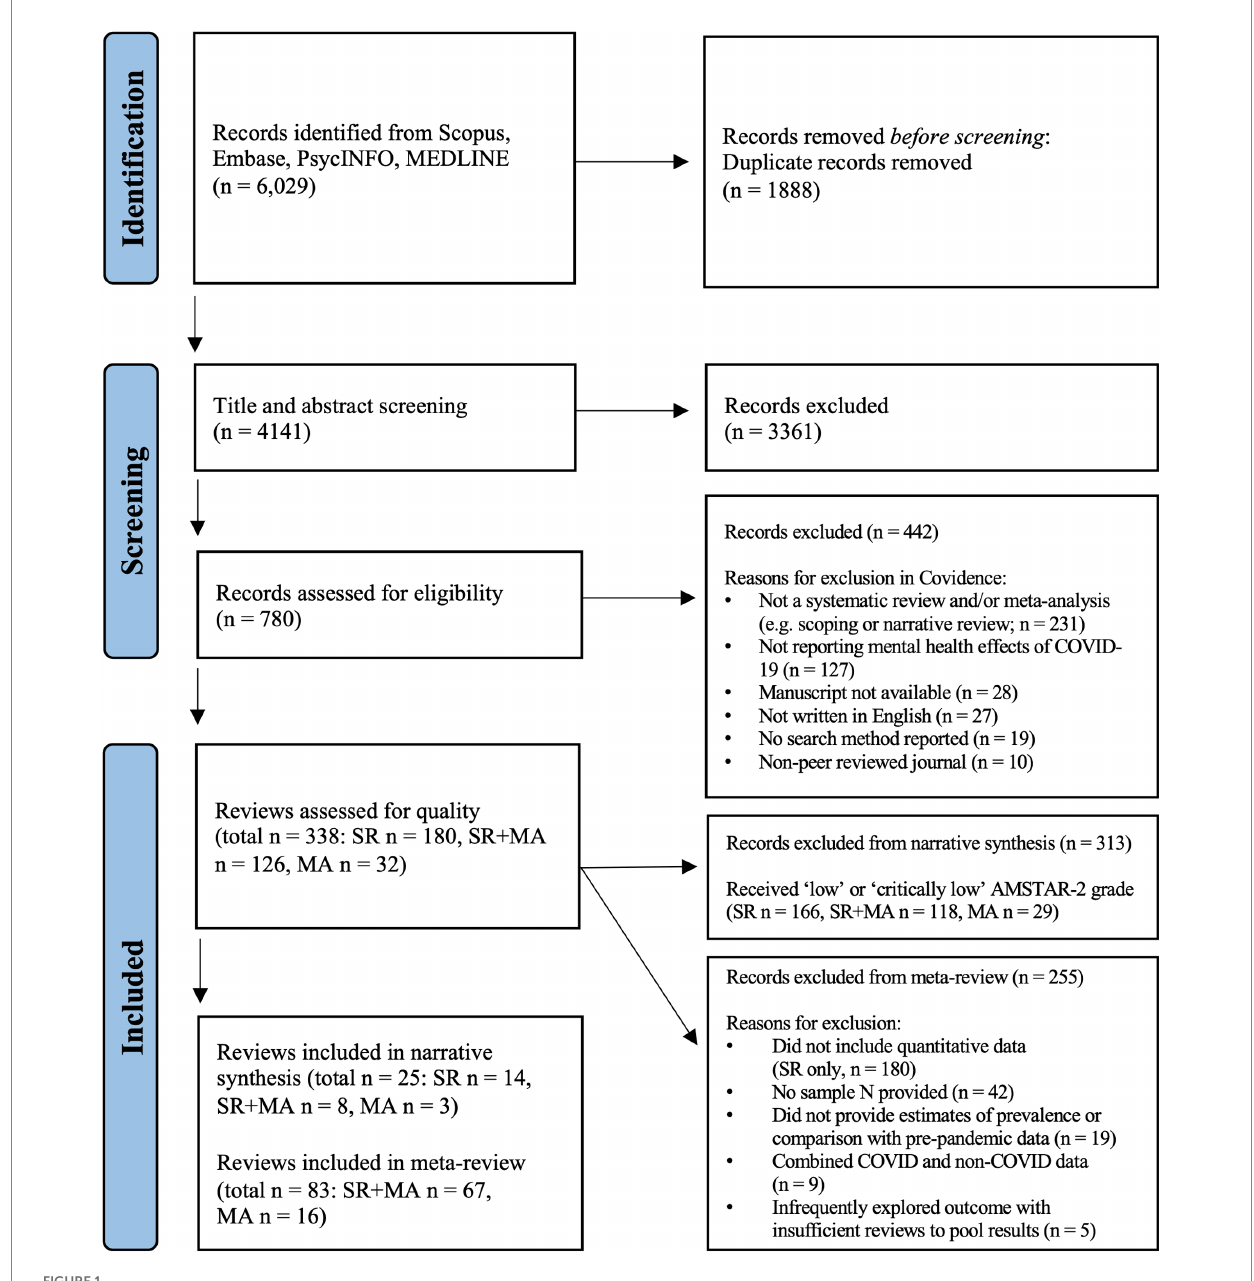
FIGURE 1 PRISMA diagram. PRISMA flow diagram outlining the progression of the 5-phase systematic search undertaken to retrieve articles examining the impact of COVID-19 on mental health outcomes. Phase 1: The initial search across four databases (Scopus, Embase, PsycINFO, MEDLINE) yielded 6,029 records, of which 1,888 articles were identified as duplicates, and removed before screening commenced. Phase 2: The titles and abstracts of 4,141 records were screened for relevance, which led to 3,361 records being excluded. Phase 3: Subsequently, 780 articles underwent full-text screening, with 442 records removed prior to quality appraisal. Phase 4: Of the 338 reviews assessed for quality using the AMSTAR-2 critical appraisal tool, 313 records were excluded from the narrative synthesis, and 255 records were excluded from the meta-review. Phase 5: Twenty-five records were included in the narrative synthesis, comprising 14 systematic reviews, 8 combined systematic reviews and meta-analyses, and 3 meta-analyses. There were 84 records included in the meta-review consisting of 67 combined systematic reviews and meta-analyses and 16 meta-analyses. n , number of records; SR, systematic review; MA, meta-analysis; SR + MA, systematic review and meta-analysis; AMSTAR-2, Assessment of Multiple Systematic Reviews Revised; PRISMA, Preferred Reporting Items for Systematic Reviews and